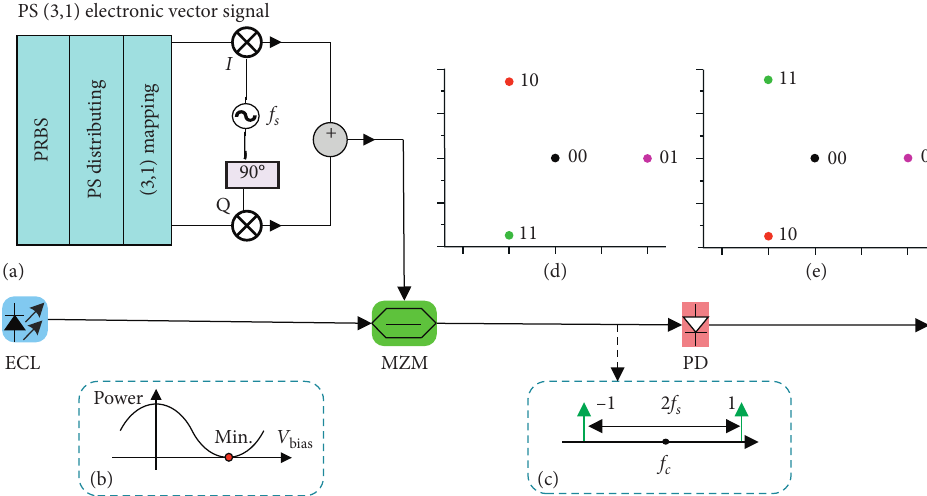
Figure 3: Schematic diagram of PS (3, 1) photonic vector signal generation: (a) the method of generating PS (3, 1) electronic vector signals; (b) relationship between MZM output power and DC bias voltage; (c) optical spectrum of the signal at the MZM output; (d) distribution of pre-PD constellation points; (e) distribution of post-PD constellation